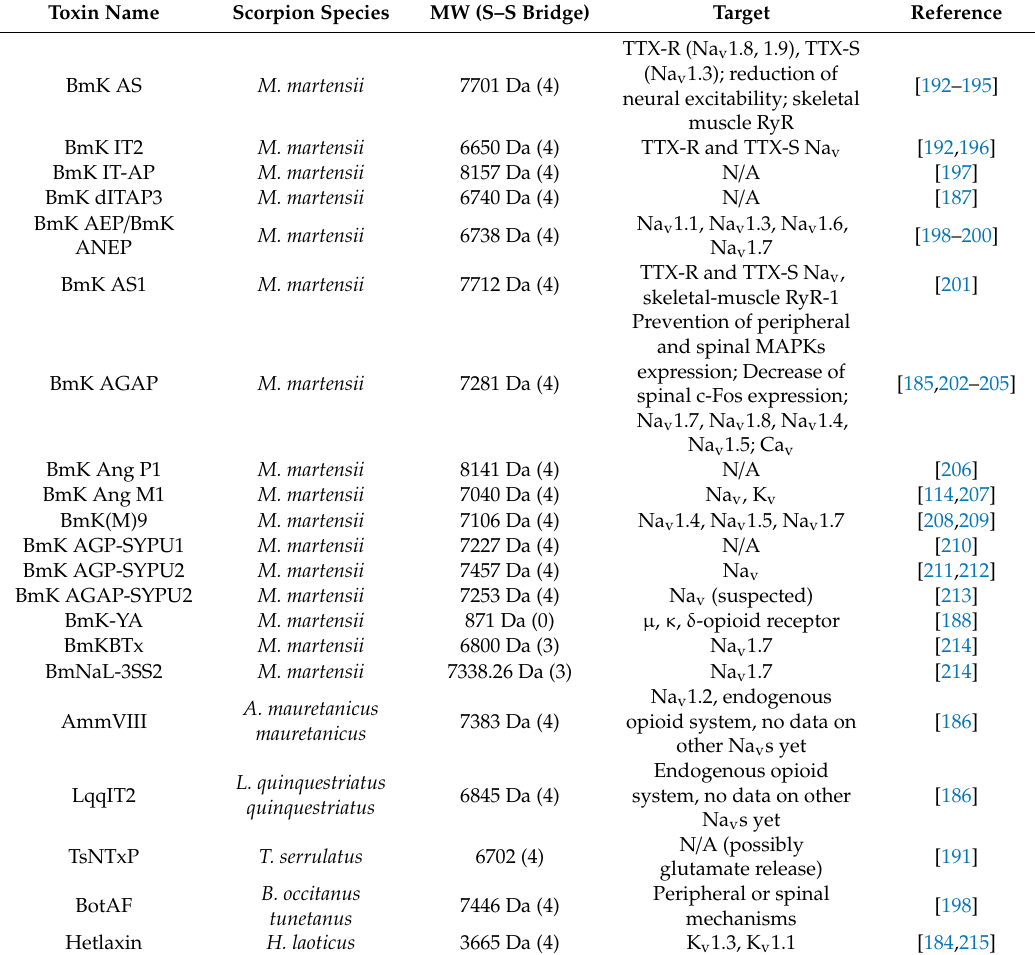
Table 3. Summary of known anti-nociceptive scorpion